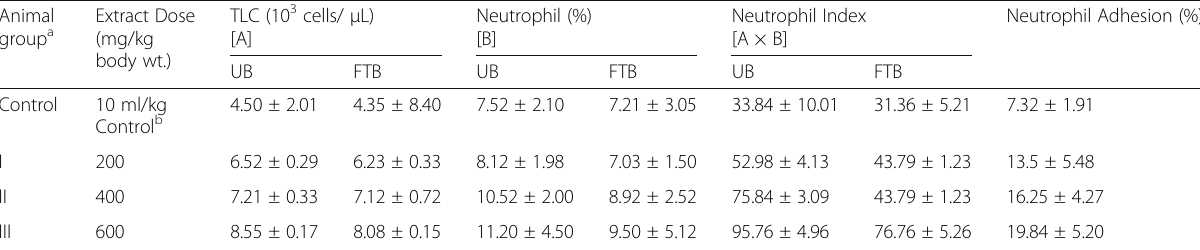
Table 9 Effect of methanolic stem extract of B. lupulina on neutrophil adhesion Animal Extract Dose group a (mg/kg body